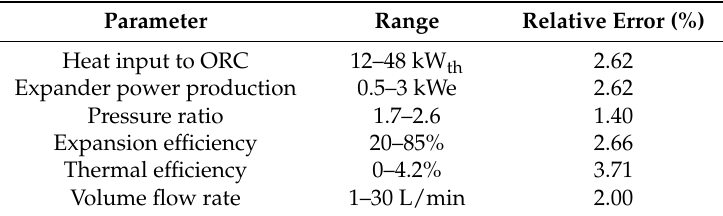
Table 3. Accuracy of calculated parameters